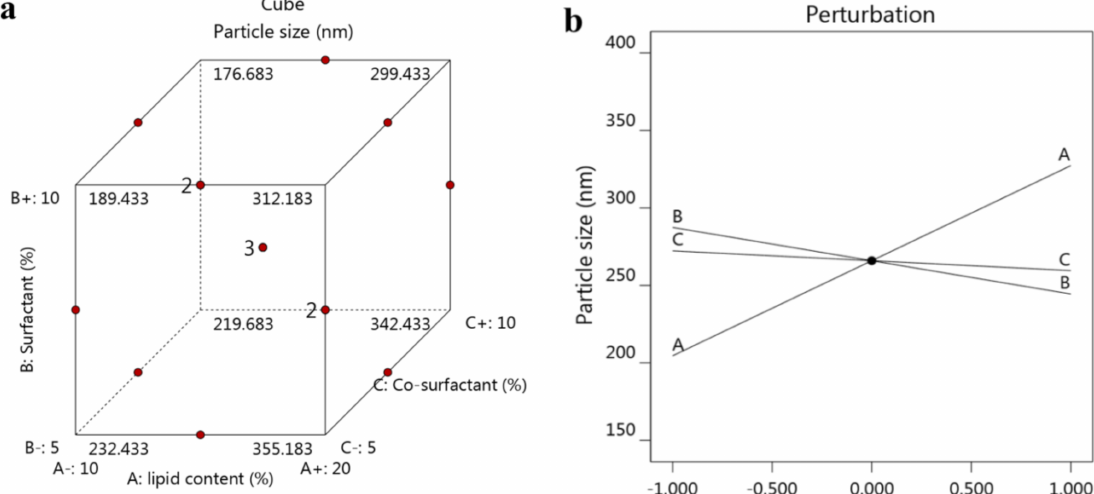
Figure 2. ( a ) Cube graph showing the predicted values and ( b ) perturbation plot displaying the influence of each independent variable alone on particle size Y 1 .